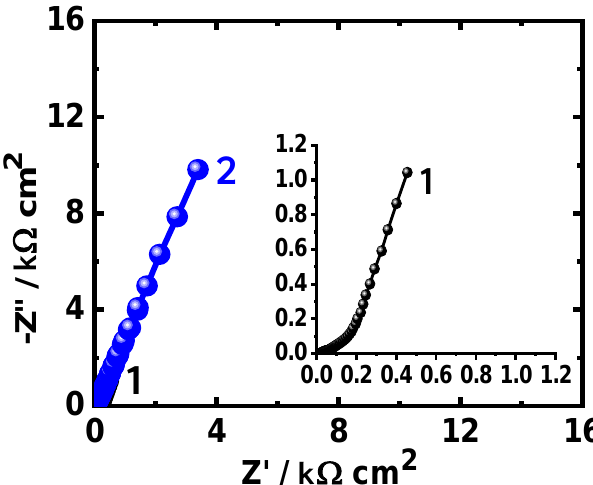
Figure 5. Nyquist plots measured for (1) Ti-6%Al and (2) Ti-6%Al-4%V alloys after immersion in 3.5% NaCl solution for 1 h.